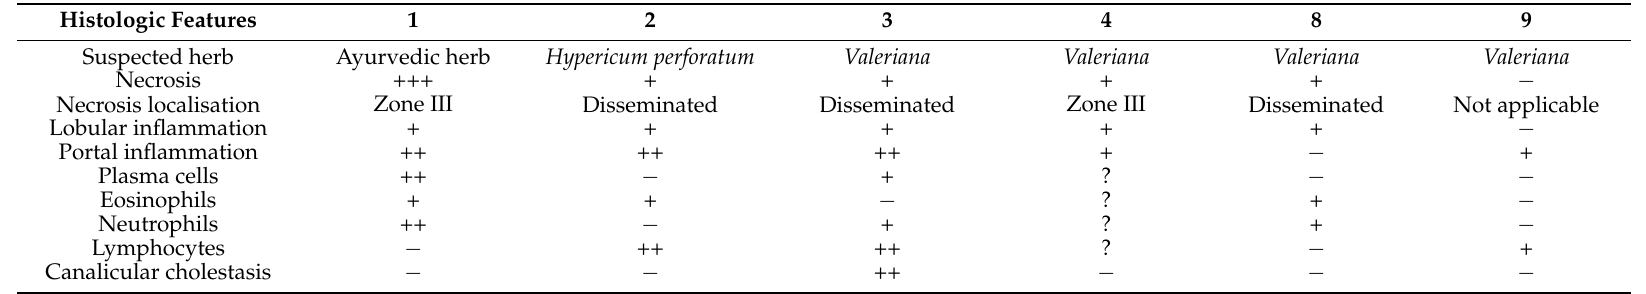
Table 2. Histologic features of the patients with herb-induced liver injury.